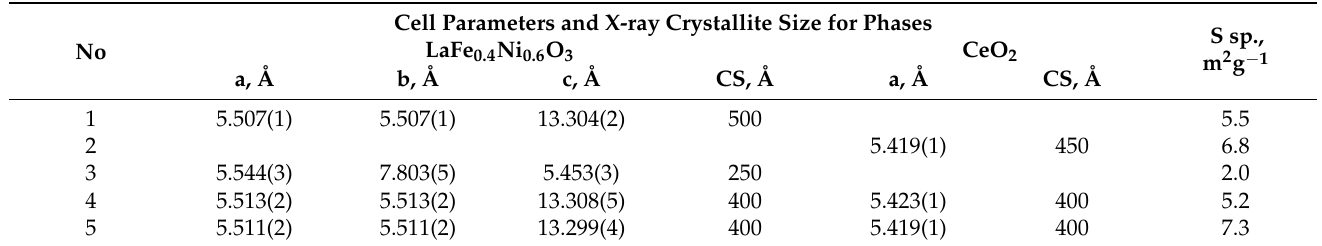
Table 2. Cell parameters and X-ray crystallite sizes for perovskite and fluorite phases in samples 1–5 (according to Table 1); specific surface area values (S sp , m 2 g − 1 ) of the samples. Cell Parameters and X-ray Crystallite Size for